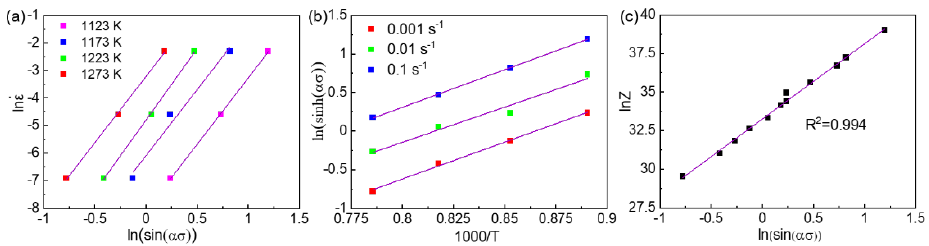
Figure 4. The relationship and linear fitting between ( a ) ln 𝜀̇ vs. ln [ sin ( 𝛼𝜎 )], ( b ) ln [ sinh ( 𝛼𝜎 )] vs. (1000/ T ), and ( c ) lnZ vs. ln [ sinh ( 𝛼𝜎 )] of the Co 35 Cr 25 Mn 15 Ni 15 Fe 10 TRIP-HEA. The hot-compression was conducted at 1123, 1173, 1223, and 1273 K with strain rates of 0.1, 0.01, and 0.001 s −1 ,